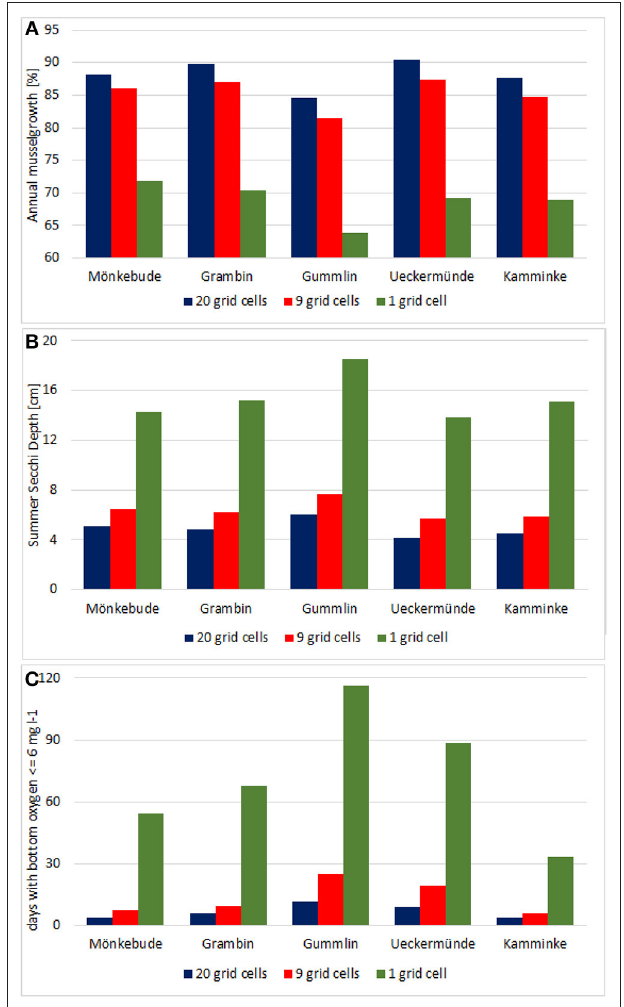
FIGURE 11 | Condensing the 5 small scale farms in option 3 to less grid cells but fixing the mussel biomass at 2,000t results in a reduced growth (A) , and an increase of the maximal Secchi Depth improvement (B) and the days per year with bottom oxygen below 6mg l − 1 (C)